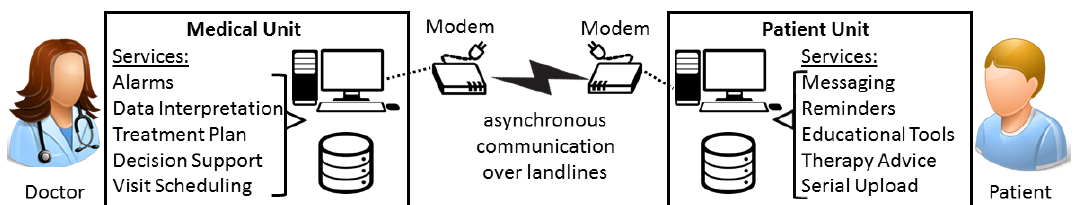
Figure 1. The early architecture adopted for the remote monitoring of Type 1 Diabetes Patients. The architecture encompassed two separate units, each one hosting different services, asynchronously communicating using modems operating over